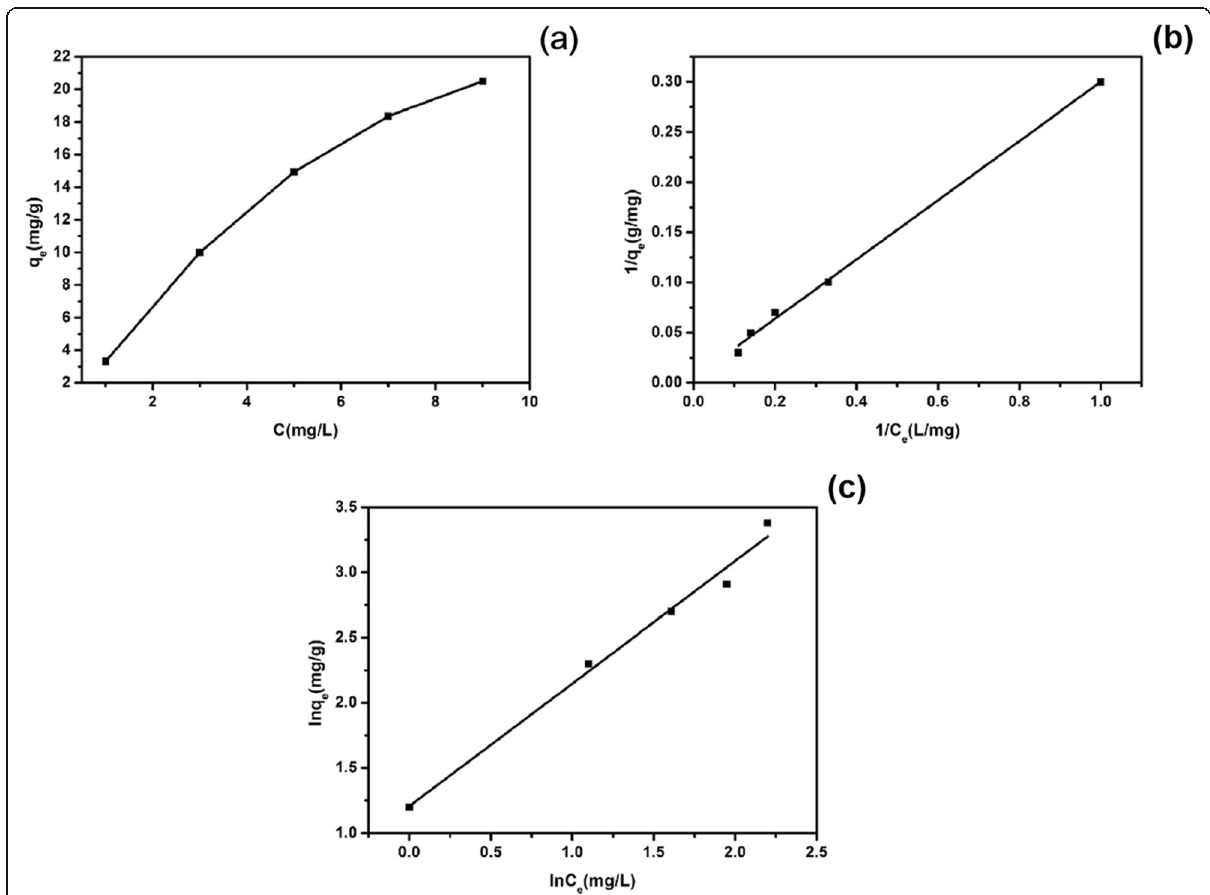
Fig. 13 Isotherm curve of 298 K copper sulfide adsorption EE2 ( a ), Langmuir isotherm curve fitting of copper sulfide adsorption EE2 ( b ), and Freundlich isotherm curve fitting of EE2 adsorbed on copper sulfide ( c )